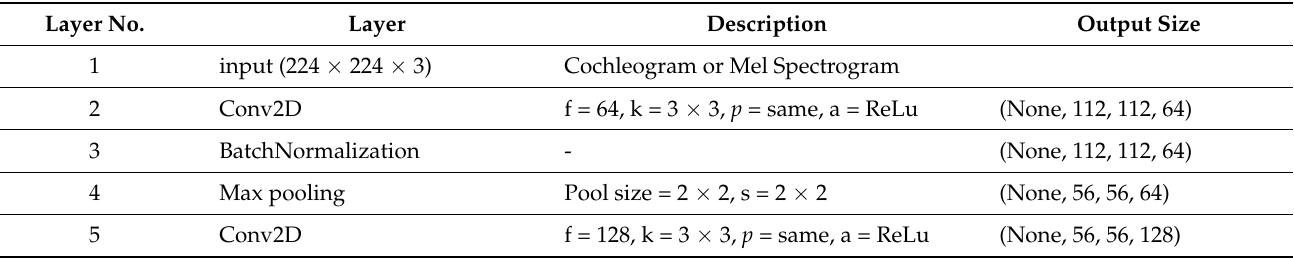
Table 1. Basic 2DCNN